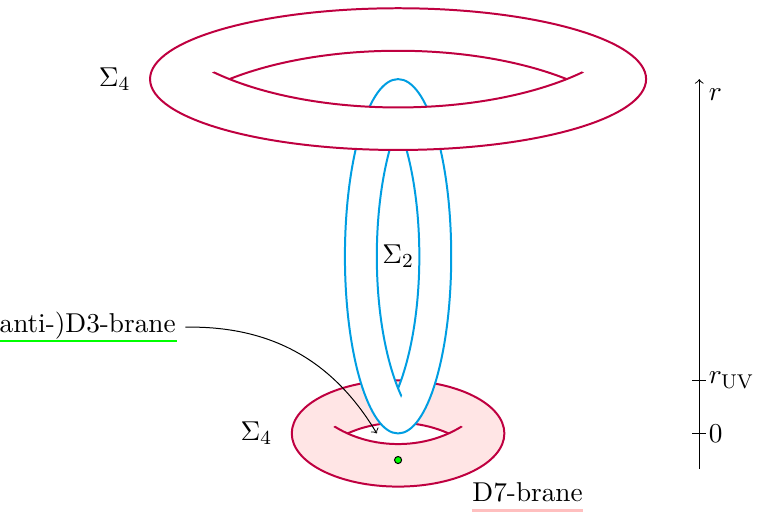
Figure 2 . A sketch of the toy configuration under consideration, with the D7-brane wrapping the 4-space at r = 0 . The D3- or anti-D3-brane provides extra open-string states, as discussed in sections 3 and 4,